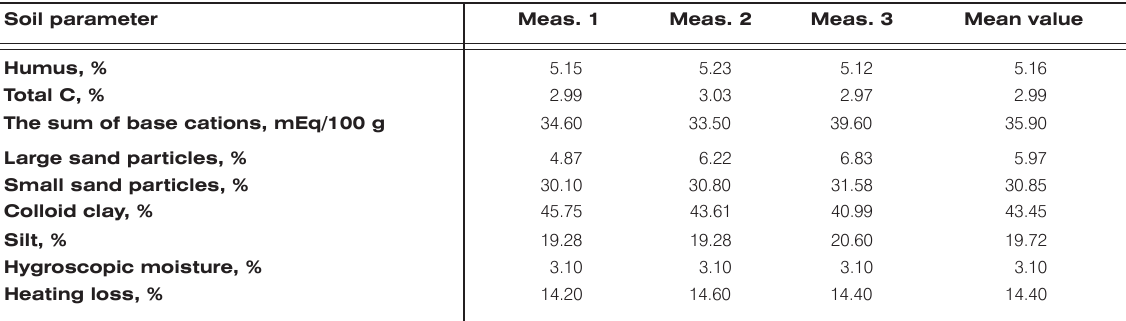
Figure 3. The comparison of the amounts of cations extracted by each of the three extraction techniques, MAE (150°C), RAE and UAE (average amount taking all extraction times in consideration). Table 3. The results of basic pedological